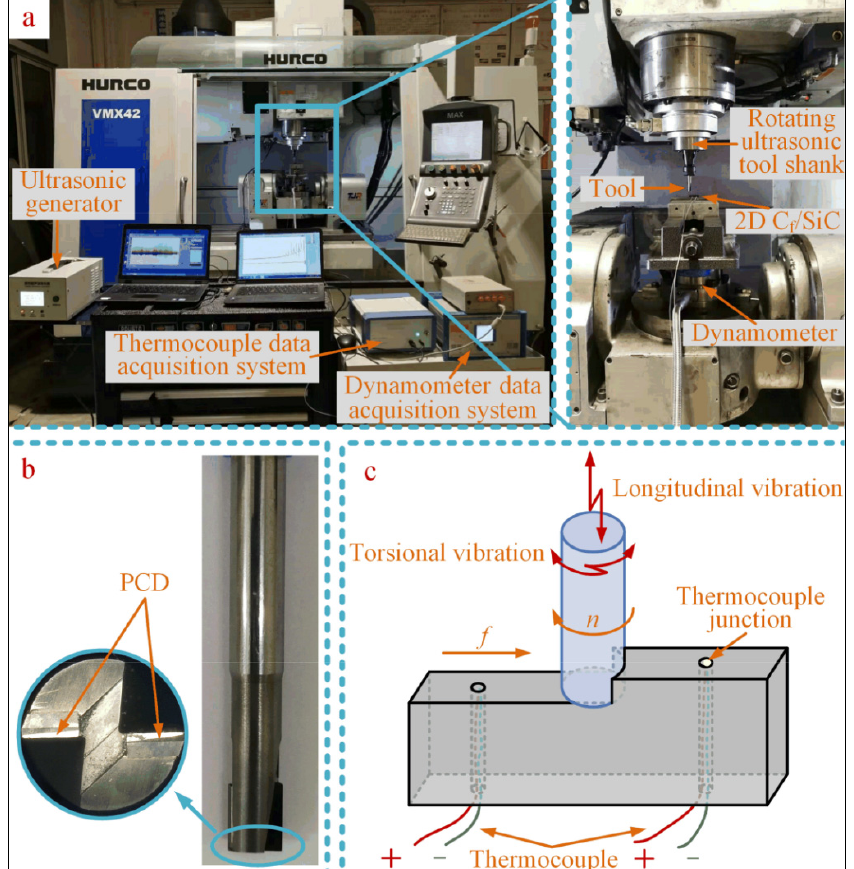
Figure 9. Experimental setup, ( a ) machining center and online testing equipment, ( b ) PCD tool, ( c ) schematic diagram of milling [124].